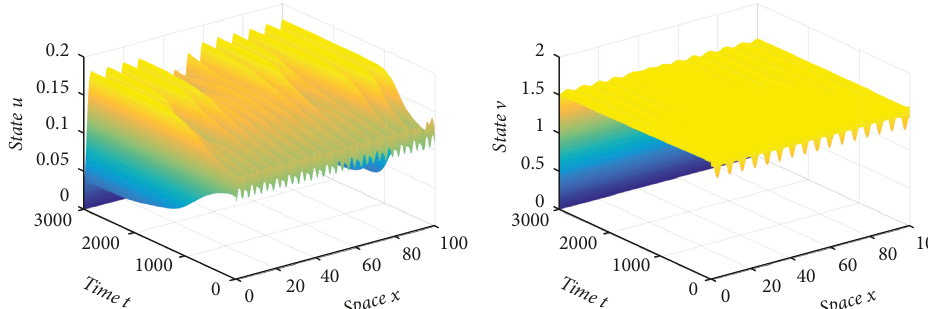
Figure 5: Spatiotemporal evolution behaviors of prey and predator of system (15) with D u ( 0 ,x ) � 0 . 119 + 0 . 1 cos x, v ( 0 , x ) � 1 . 535 + 0 . 5 cos x .